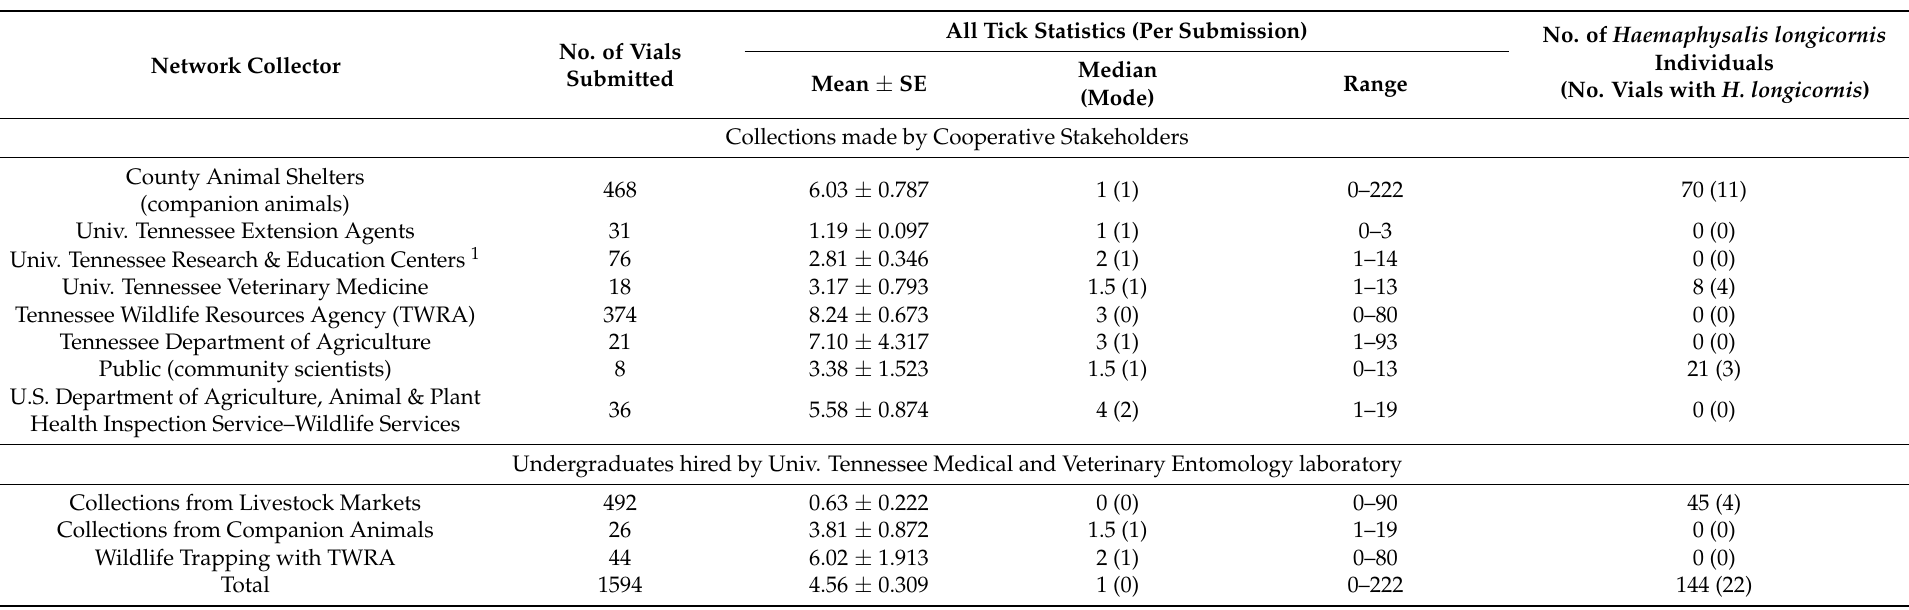
Table 1. Summary of tick collections submitted by cooperating stakeholder groups in Tennessee, USA, March 2019–February